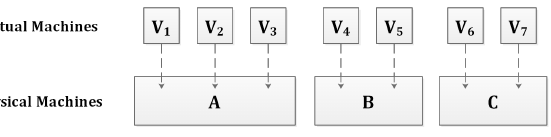
Figure 4. Virtual machine group